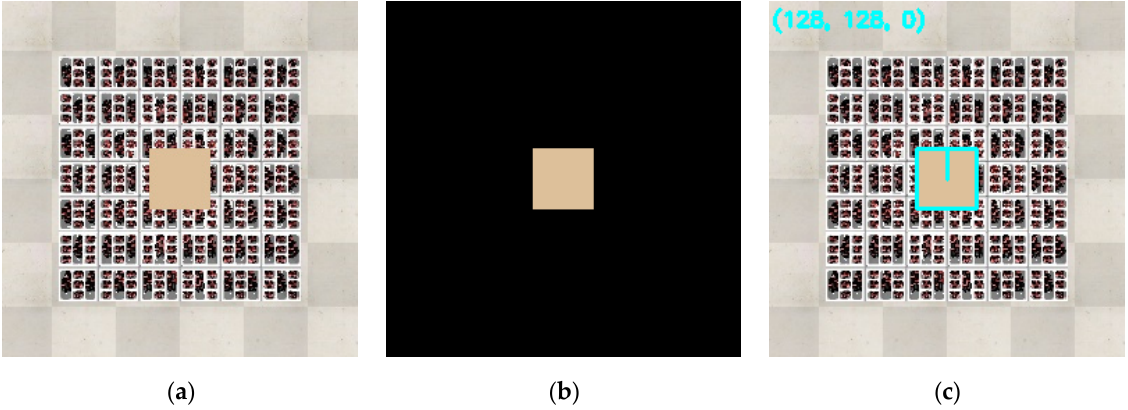
Figure 9. ( a ) Raw image of EOCC and carton. ( b ) Mask of the image after processing. ( c ) Final processed image with (128, 128, 0) indicating the absolute position and orientation of the carton.